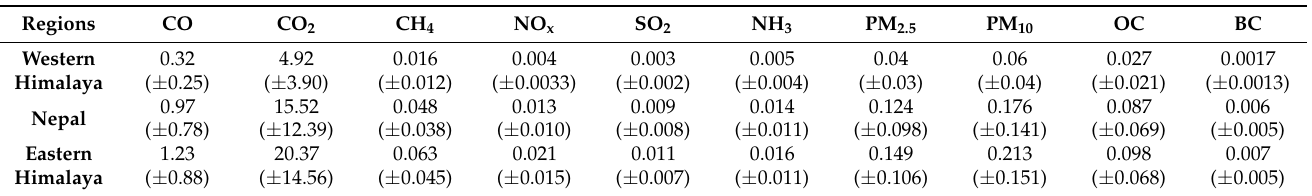
Figure 4. Inter-annual (2001–2020) variations of emissions (Tg) from forest fire over western to eastern Himalaya. Table 3. The annual average and stand deviation of emissions (Tg year − 1 ) from forest fire over the